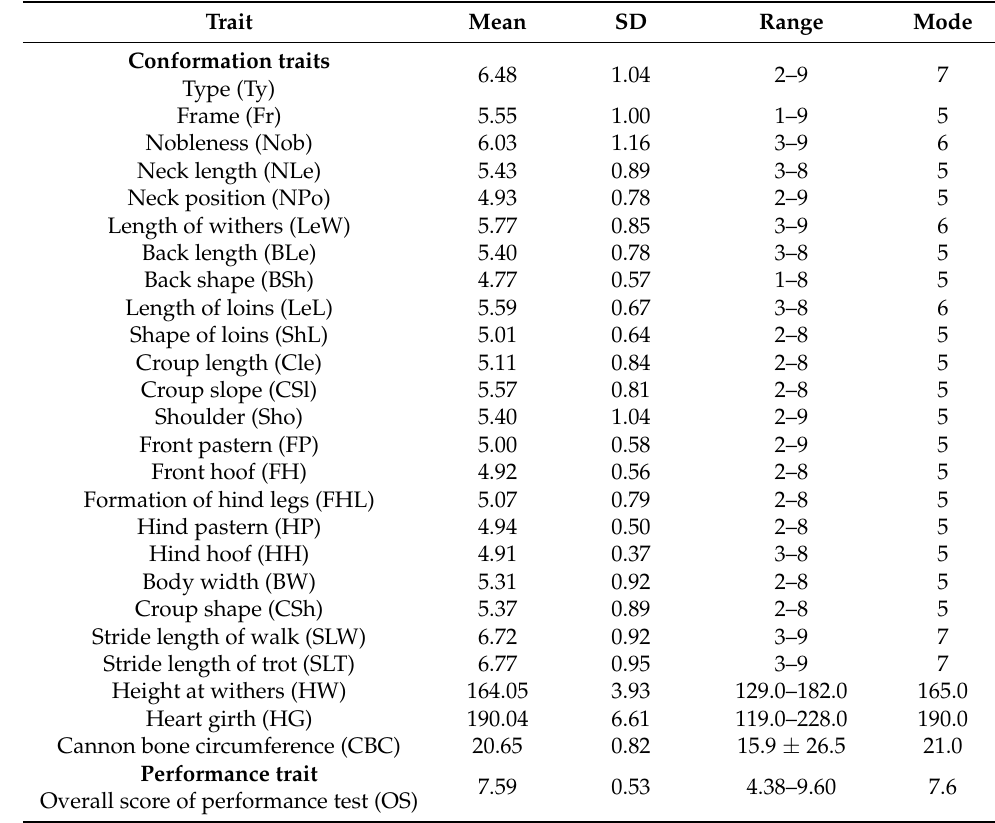
Table 2. Descriptive statistics of the 26 evaluated